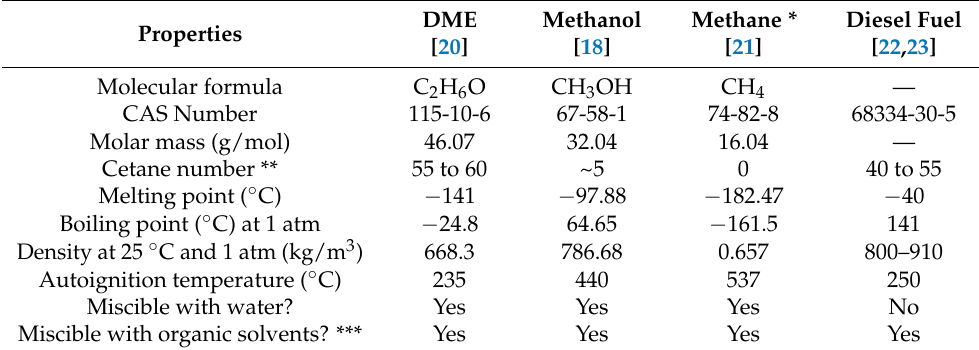
Table 1. Properties of DME and methanol compared with other